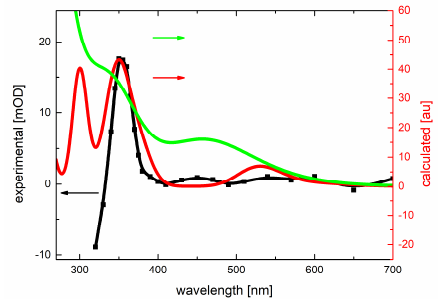
Figure 10. Comparison of the transient absorption spectrum recorded in N 2 O-saturated aqueous solutions containing 0.1 mM 3-MeQ and 0.1 M NaN 3 at pH = 7 ( ■ , ▬) and the u-ωB97XD/aug-cc-